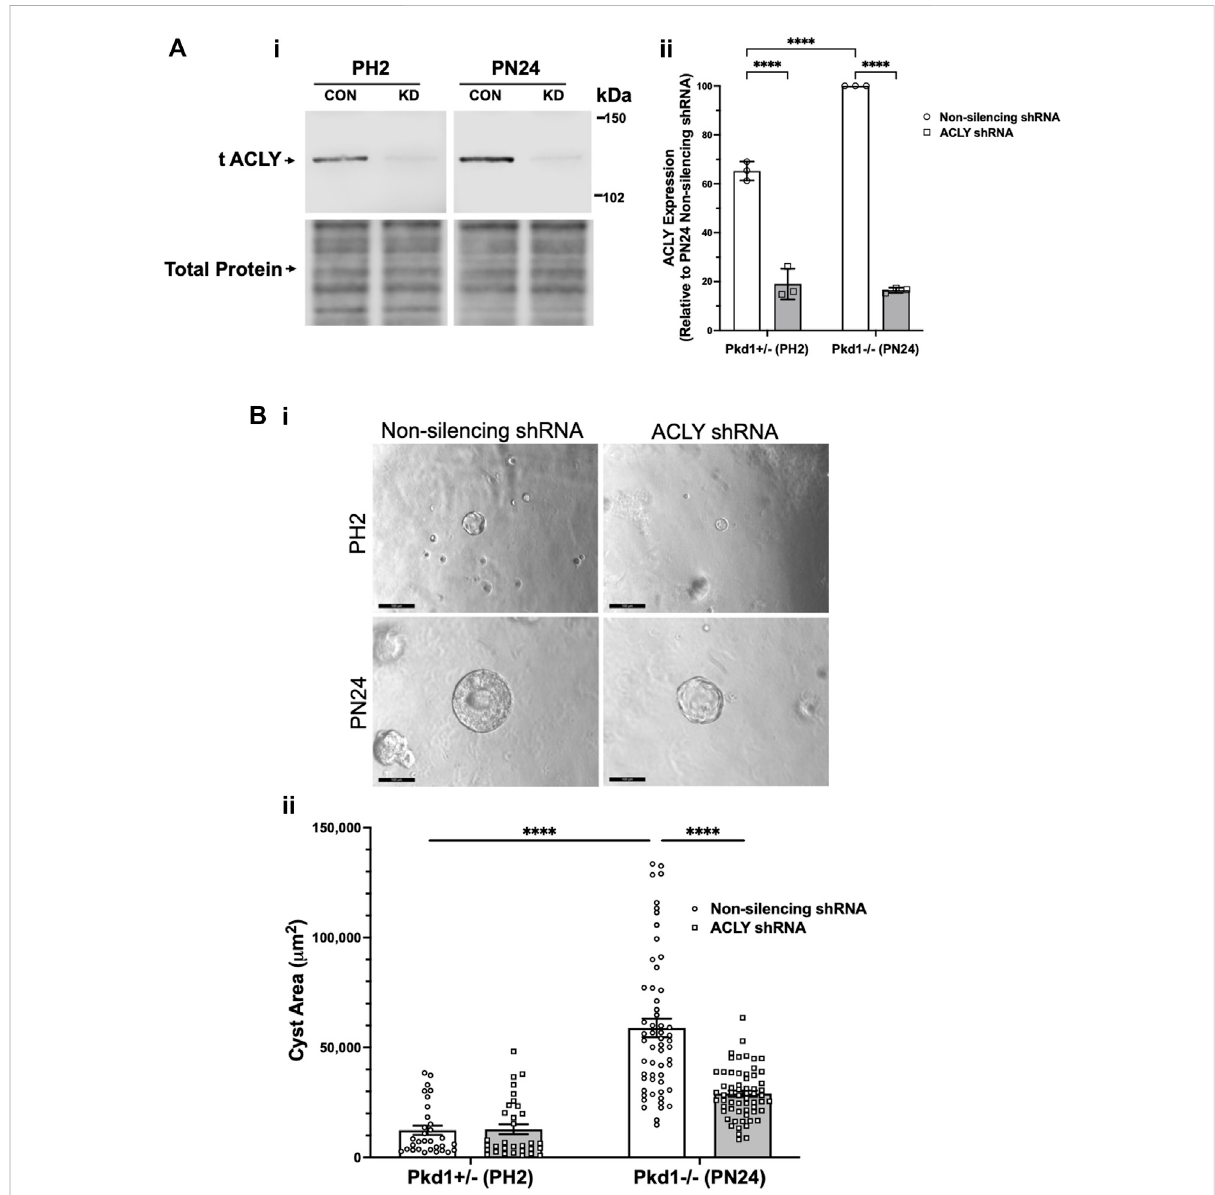
Aclyknockdowninhibitscysticgrowthin3DculturesofPT-derivedkidneyepithelialcells. (A) StablePT-derivedcelllinesexpressingeithernon- silencing control shRNA or shRNA against Acly were generated and checked for ACLY protein expression by immunoblotting analysis. i Representative immunoblotting of ACLY proteinexpression in the different cell lines. ii Summary data reveal that Pkd1 +/ − (PH2) cells expressing non- silencing controlshRNAhave~35%reducedACLYexpressioncomparedwith ACLYexpressionin Pkd1 − / − (PN24) cellsexpressingnon-silencing control shRNA. There were means of 71% and 83% knockdown of ACLY expression in PH2 and PN24 cells, respectively, expressing shRNA against ACLY relative to ACLY expression in cells expressing non-silencing control shRNA ( n = 3, **** p < 0.0001 for the indicated comparisons). (B) Pkd1 − / − (PN24) cells developed signi fi cantly larger cysts than Pkd1 +/ − (PH2) cells, and shRNA-mediated Acly knockdown inhibited cyst growth of Pkd1 − / − (PN24) kidney epithelial cells in 3D culture. Cells were cultured for a total of 12 days in Matrigel supplemented with forskolin + IBMX after day 1, and cysts wereimagedand cyst size was analyzed as described in Materials and Methods. i Representative images of cystic structures in thedifferent cell lines. ii Summary data reveal Pkd1 − / − (PN24) cells developed signi fi cantly larger cysts than Pkd1 +/ − (PH2) cells ( n = 31 – 57 cysts analyzed